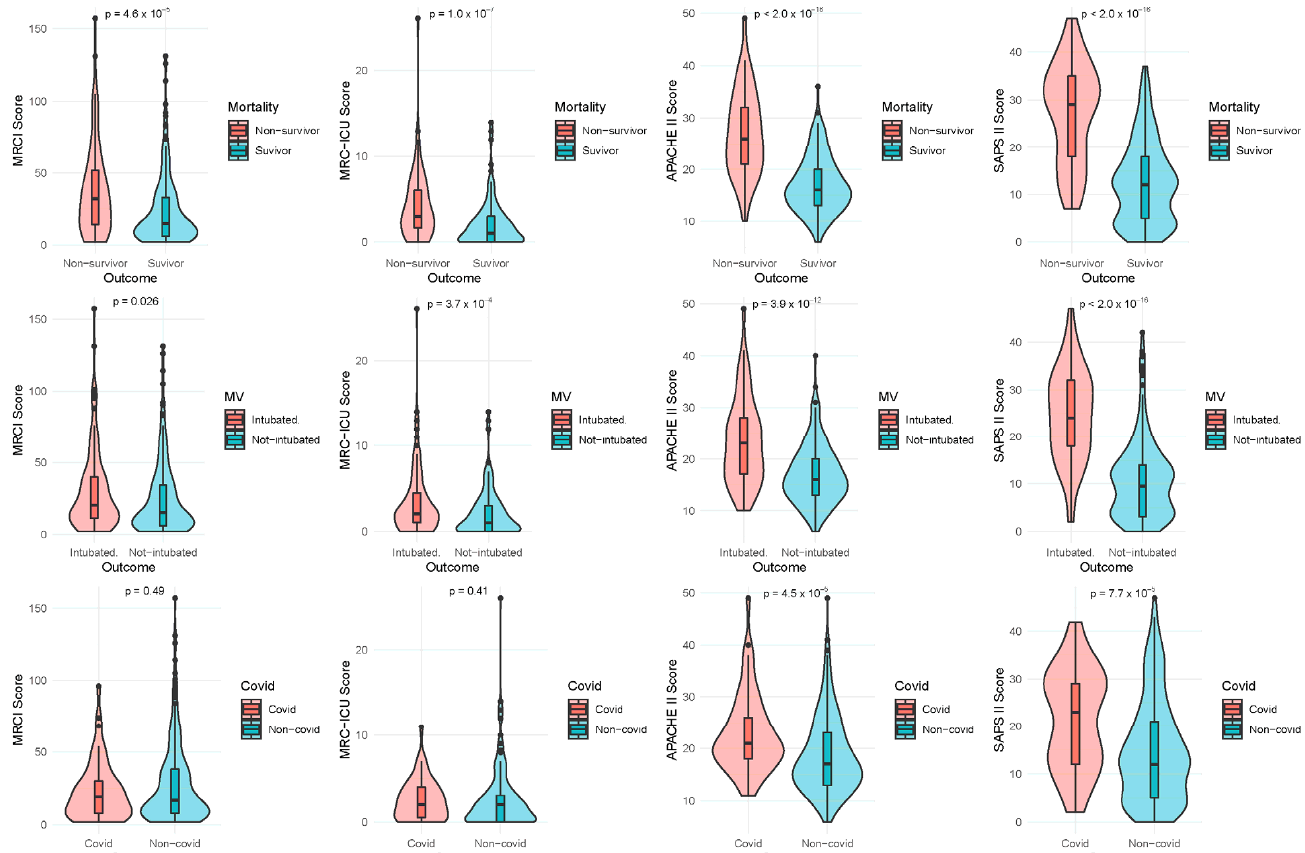
Figure 1. Comparisons among the severity score and MRC scores. Comparison of the severity-of-illness scores Acute Physiology and Chronic Health Evaluation (APACHE II), Simplified Acute Physiology Score (SAPS) II, Medication Regimen Complexity Index (MRCI), and Medication Regimen Complexity for the Intensive Care Unit (MRC-ICU) between survivors and non-survivors.